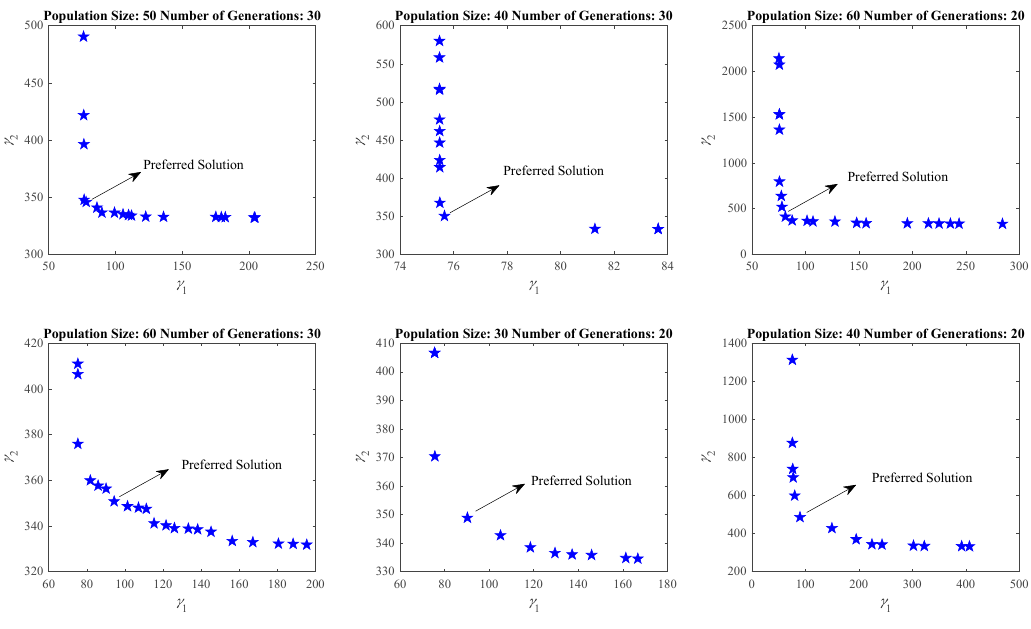
Figure 20. Pareto fronts of different changed optimization parameters.